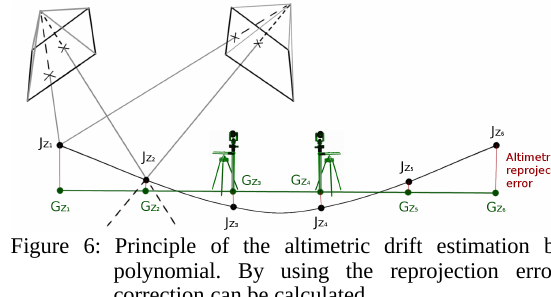
Figure 6: Principle of the altimetric drift estimation by a